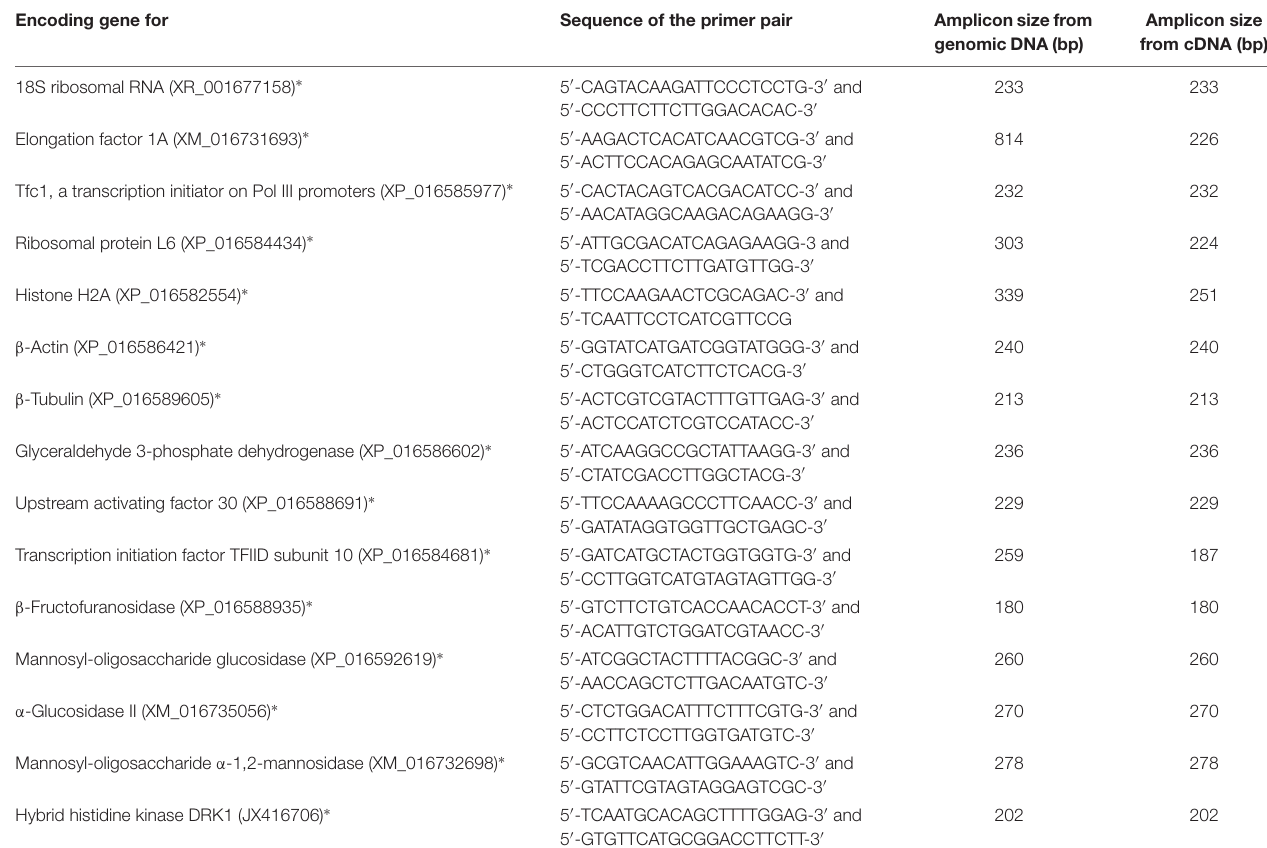
TABLE 1 | Oligonucleotide primers used in this study. Encoding gene